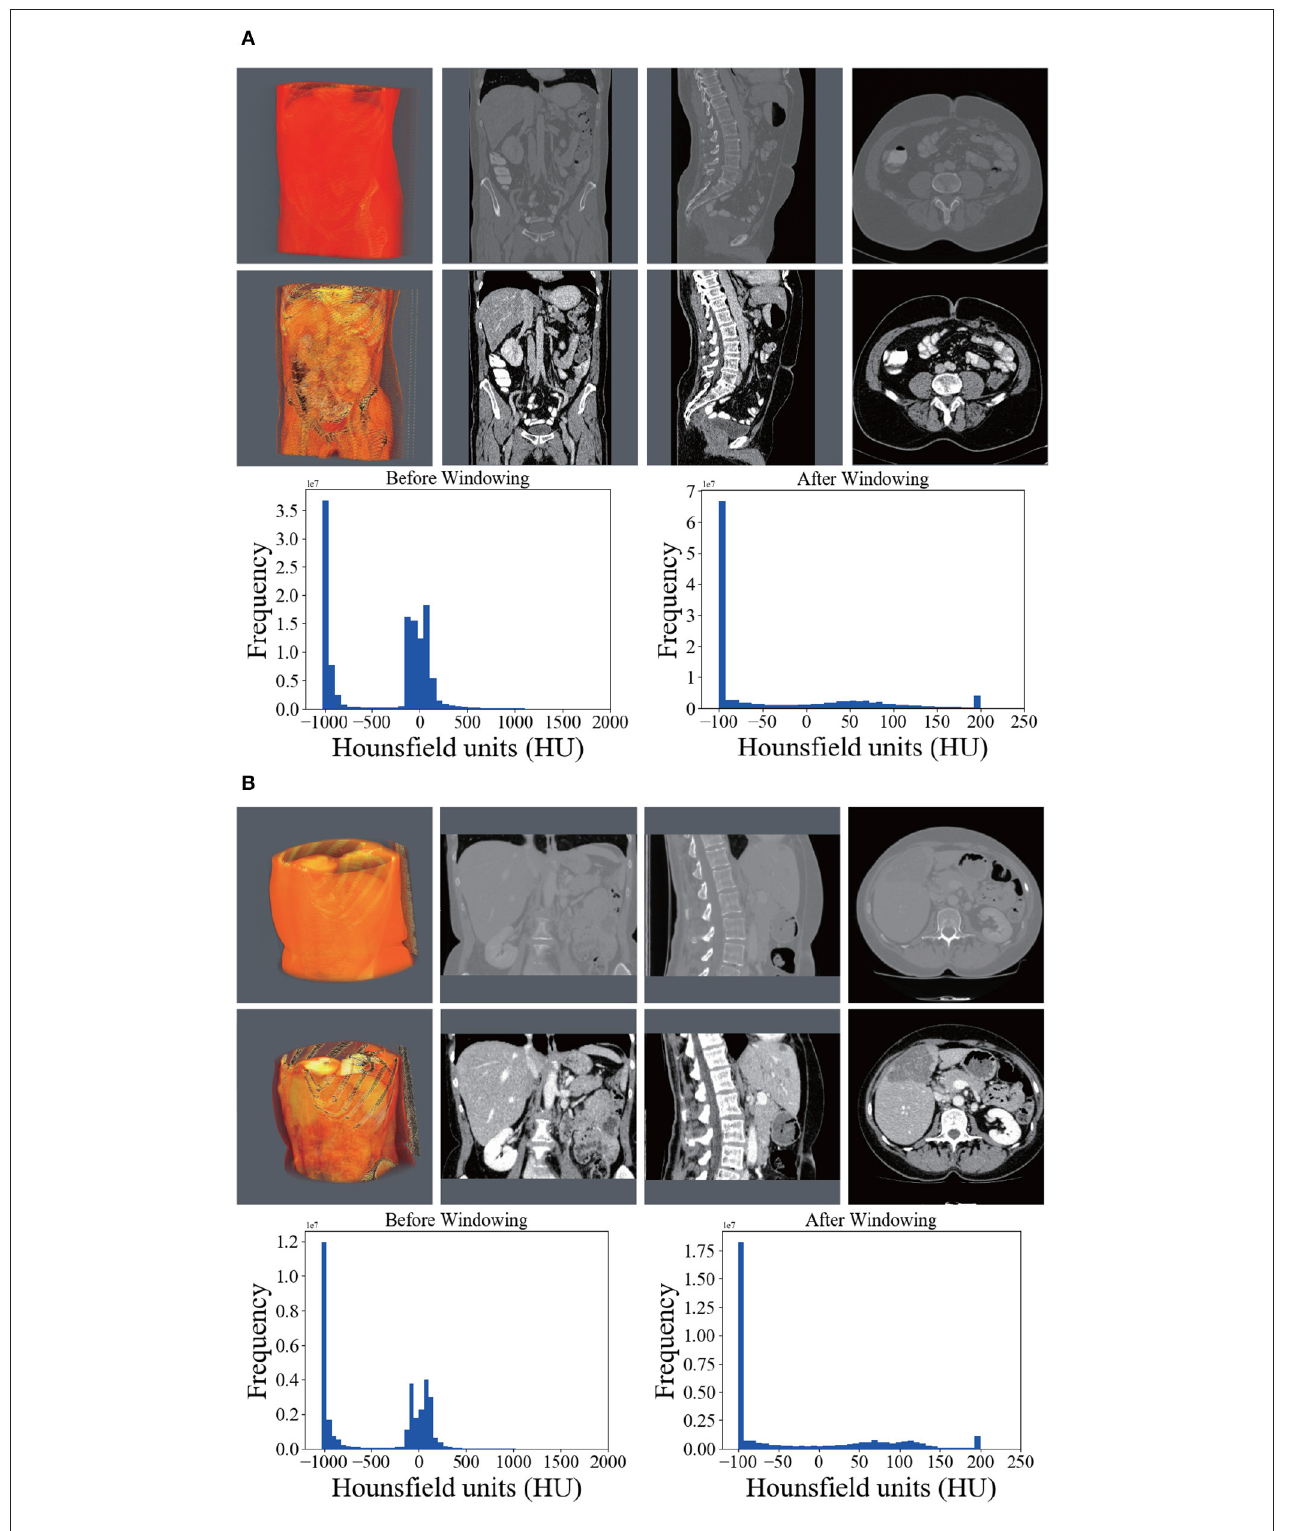
FIGURE 3 | Comparison between the raw CT scans (first row), windowed (second row) scans, and histograms of HU (third row) before and after windowing. (A) Shows the comparison on LiTS. (B) Shows the comparison on 3DIRCADb.